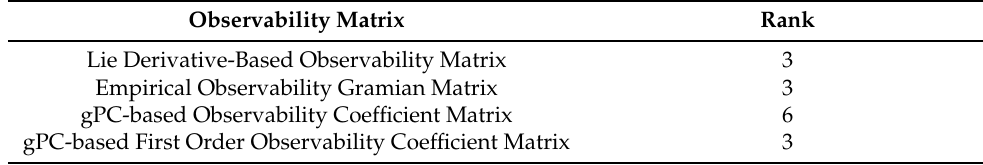
Table 1. The rank of observability matrices calculated via three approaches. Observability Matrix